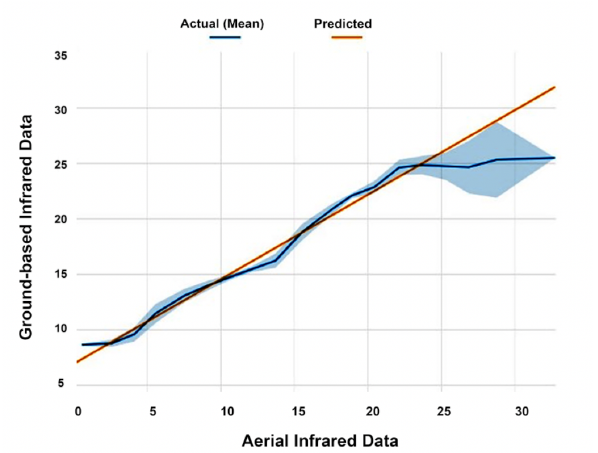
Figure 9. Linear regression pattern between aerial infrared data and ground-based infrared